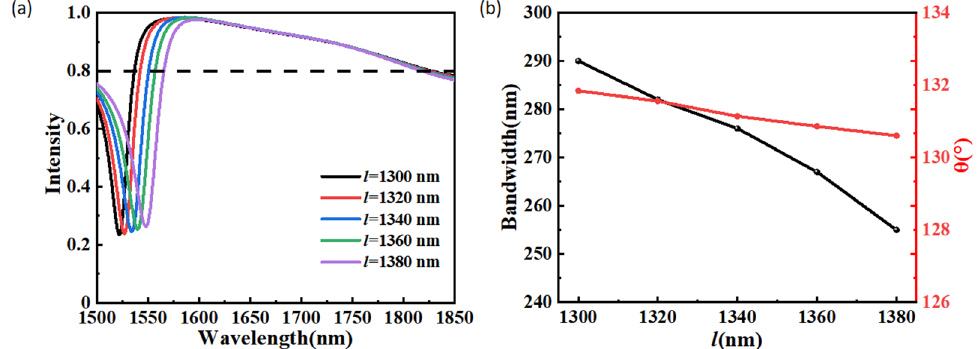
Figure 5. ( a ) Anomalous transmission intensity of the beam splitter at different values of l . ( b ) Operating bandwidth and the maximum beam split angle in the operating bandwidth at different values of l . Operating bandwidth is defined as the anomalous transmission intensity greater than 0.8.